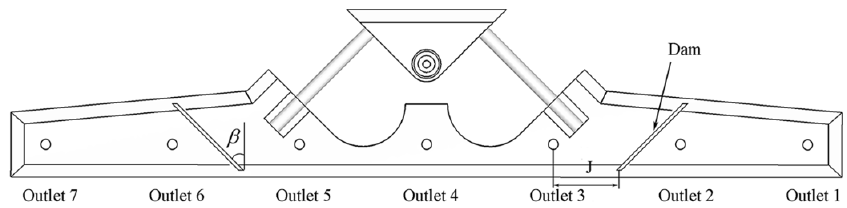
Figure 3. Top view of the optimization structure of the isothermal experiment Part B. Table 4. Scheme of the isothermal experiment Part B.